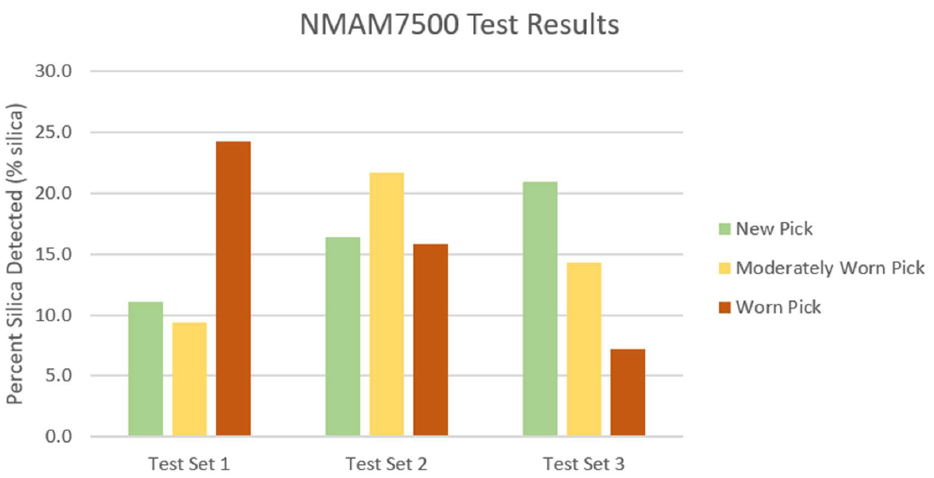
Figure 7. Percent silica detected per total sample of the suspended respirable limestone dust generated from each pick wear for the three test sets.